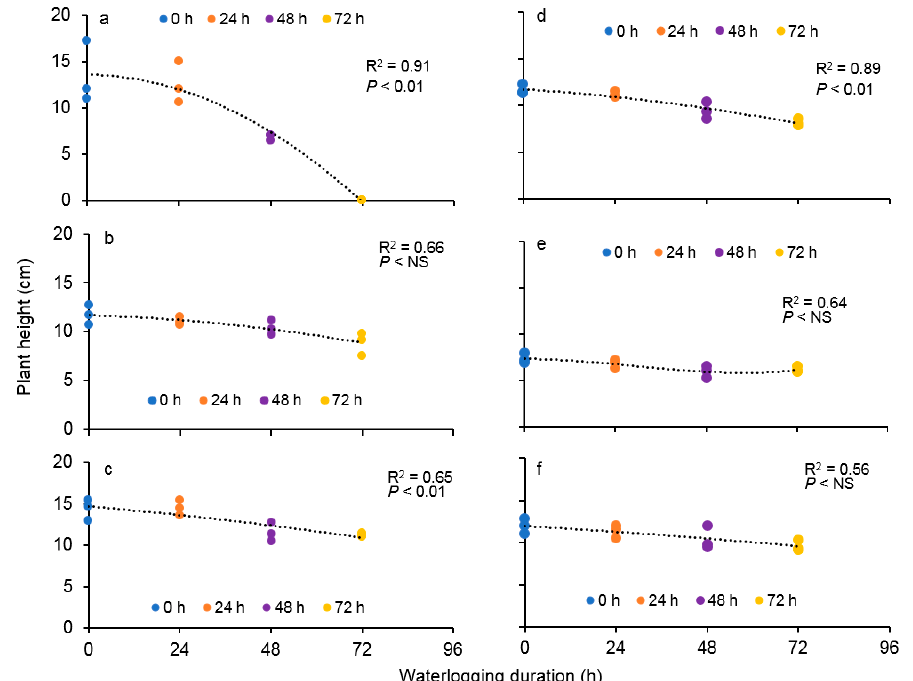
Figure 3. Effect of different waterlogging durations on sunflower plant height for early sowing ( a ) emergence, ( b ) 2-leaf stage and ( c ) 4-leaf stage, and for late sowing ( d ) emergence, ( e ) 2-leaf stage and ( f ) 4-leaf stage. Each value was the mean of three replications.